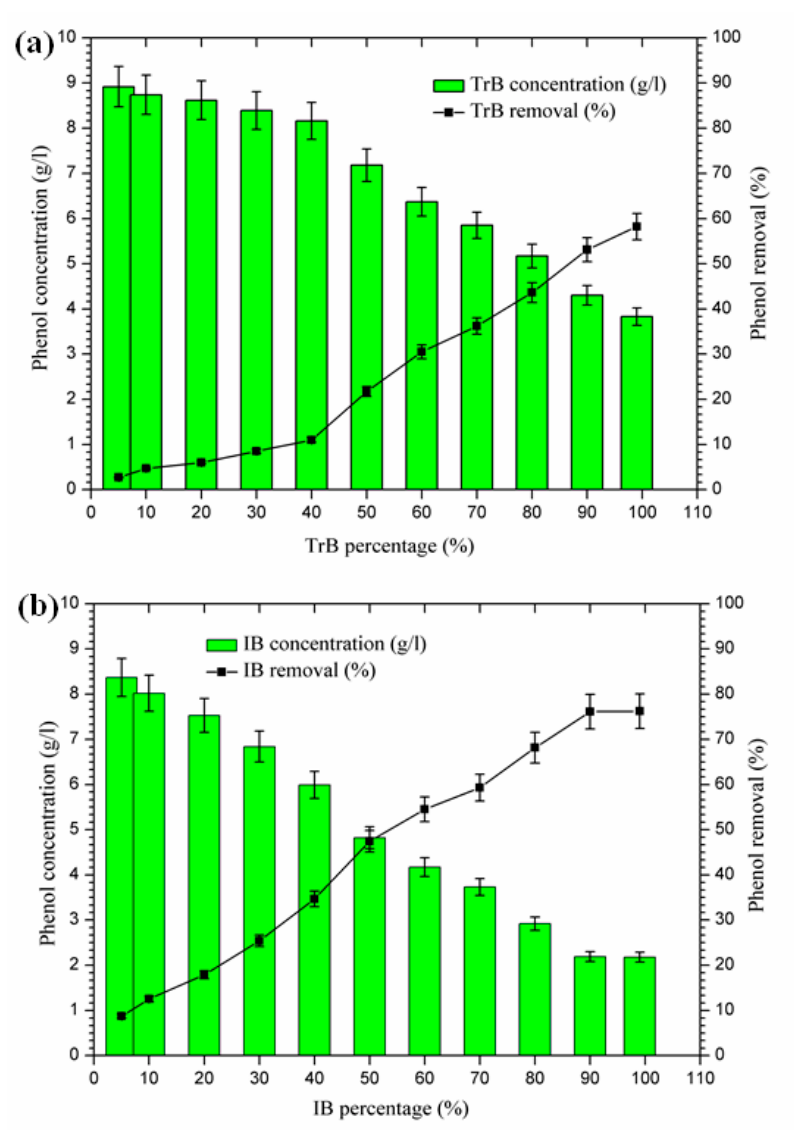
Figure 9. ( a ) Concentration and removal percentage of the phenol by TrB; ( b ) concentration and removal percentage of the phenol by IB.